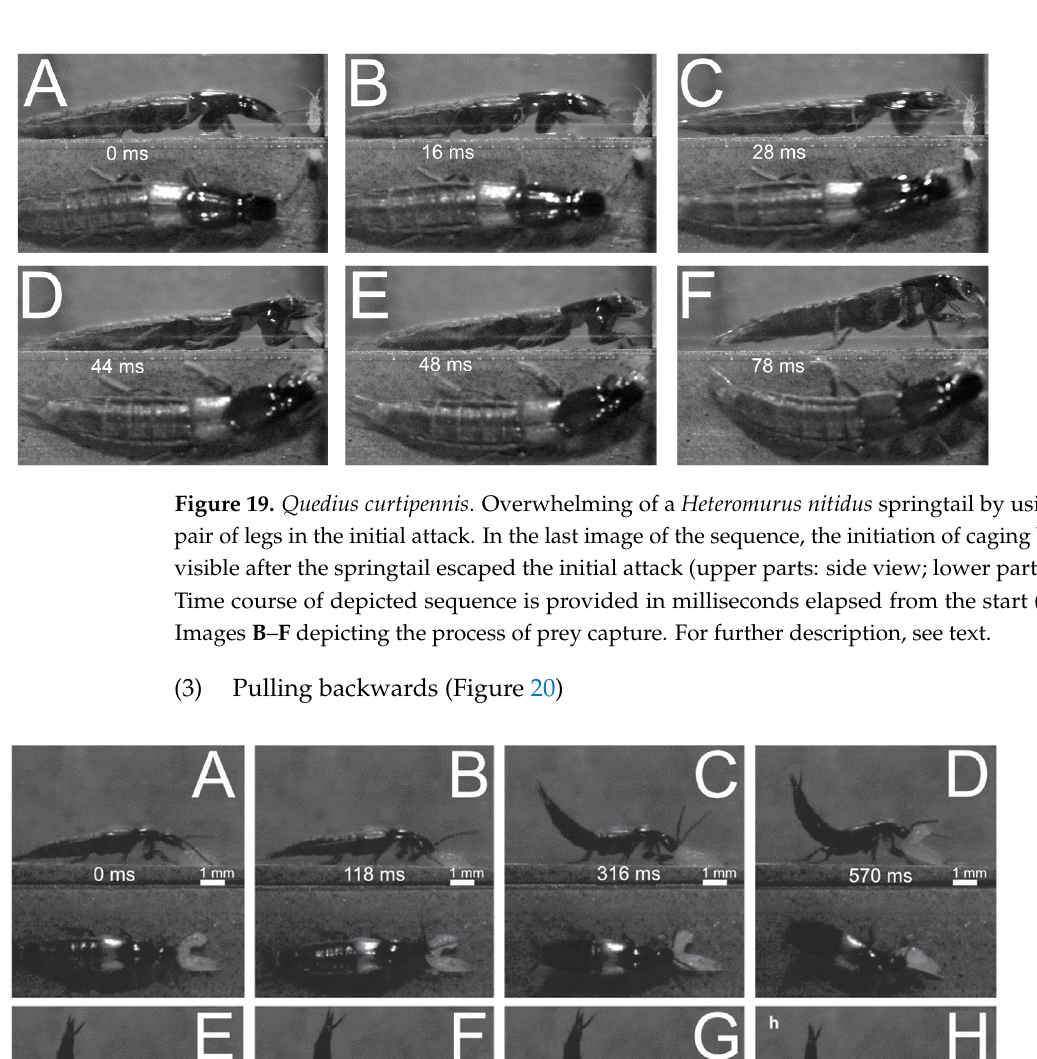
Figure 19. Quedius curtipennis . Overwhelming of a Heteromurus nitidus springtail by using the front pair of legs in the initial attack. In the last image of the sequence, the initiation of caging behaviour is visible after the springtail escaped the initial attack (upper parts: side view; lower parts: top view). Time course of depicted sequence is provided in milliseconds elapsed from the start (= image A ). Images B – F depicting the process of prey capture. For further description, see text.